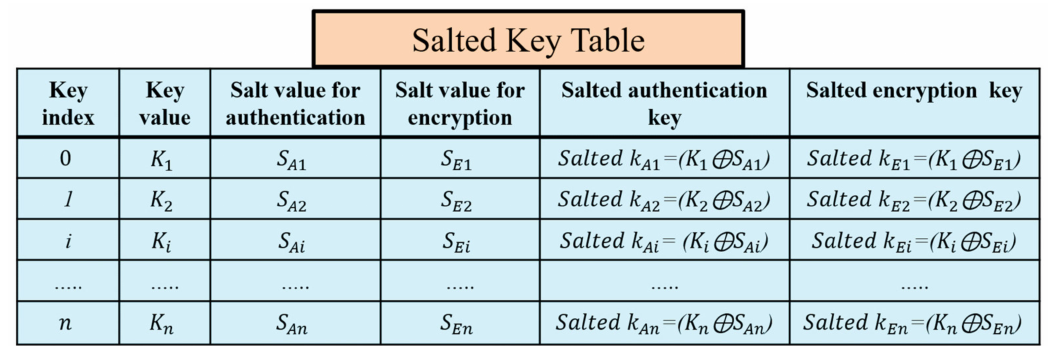
Figure 7. The self-generation of authentication and encryption salted keys at the end